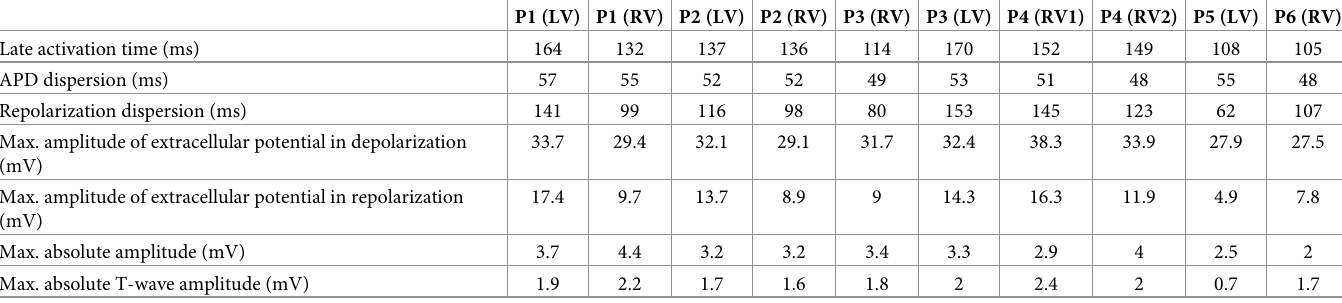
Table 5. Characteristics of ventricular repolarization and depolarization in the reference